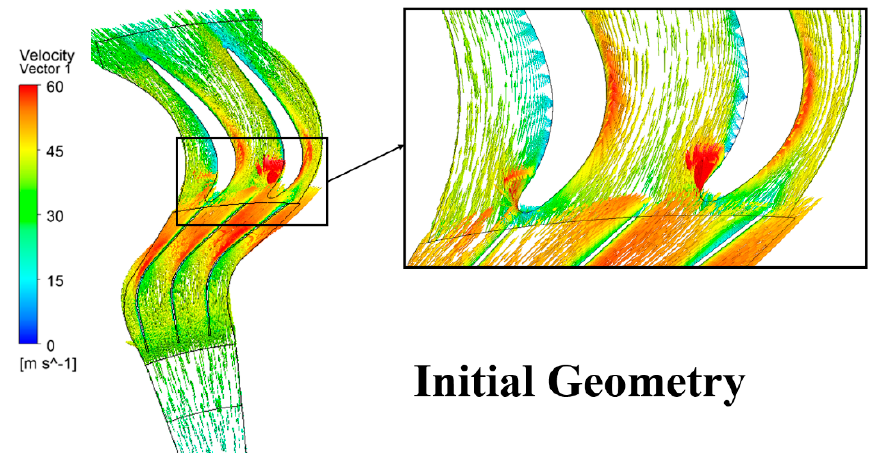
Figure 15. Velocity vectors in the turbine domain of the initial geometry at ∆ P 0 = 1400 Pa.